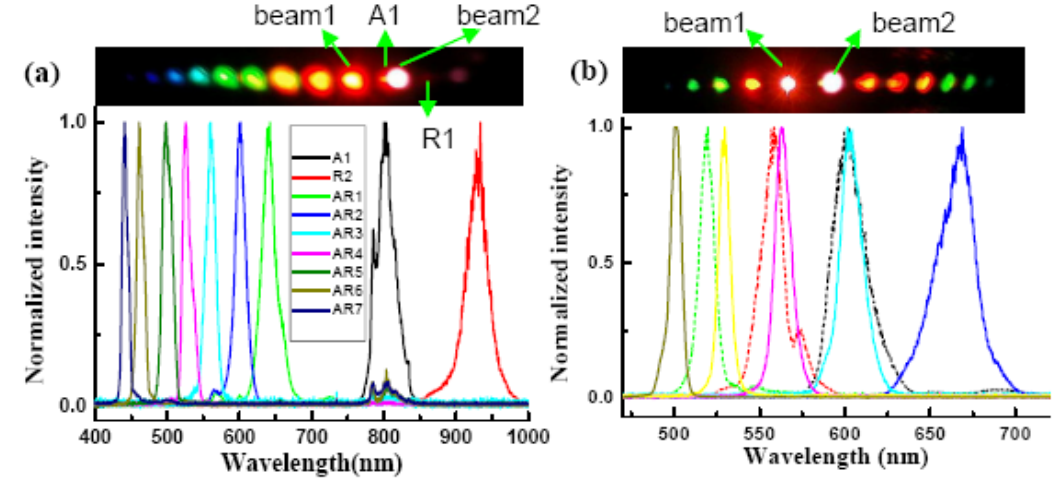
Figure 24. Photographs and spectra of the sidebands light (a) when a short-wavelength-pass glass filter with a cut wavelength at 820 nm was used in beam1 path; (b) when no glass filter was used in beam1 path. AR m ( m = 1 – 7) refers to the m th-order upshifted spectrum, and R n ( n = 2) refers to the n th-order downshifted spectrum